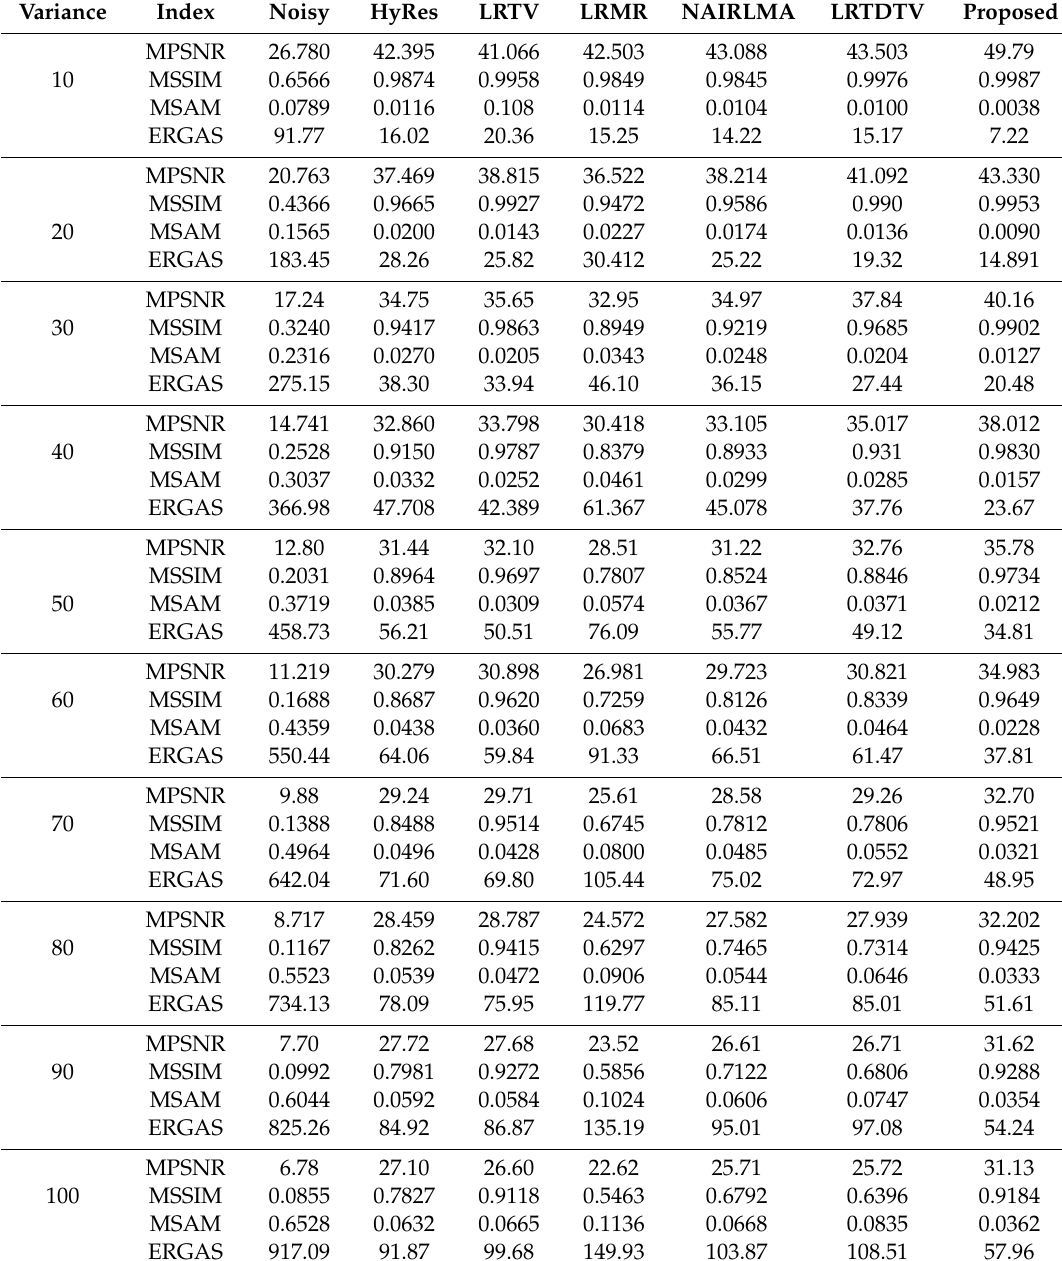
Table 2. Quantitative comparison of all of the compared methods under di ff erent noise variances for the Indian Pines